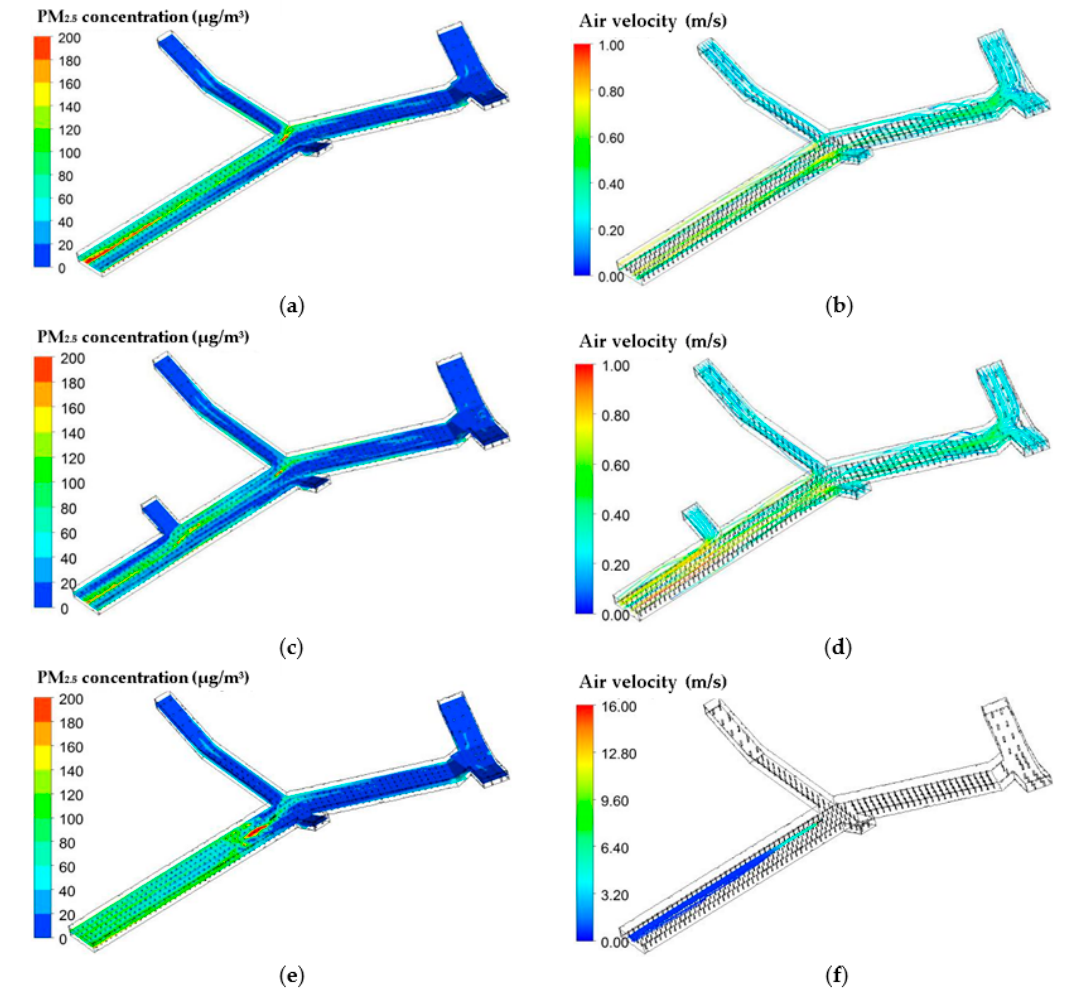
Figure 8. PM 2.5 distribution at the height of 1.5 m and wind streamline of the passageway with different ventilation modes. ( a ) PM 2.5 concentration at the height of 1.5 m in the passageway without ventilation equipment; ( b ) Wind streamline in the passageway without ventilation equipment; ( c ) PM 2.5 concentration at the height of 1.5 m in the passageway with an additional entrance; ( d ) Wind streamline in the passageway with an additional entrance; ( e ) PM 2.5 concentration at the height of 1.5 m in the passageway with a jet fan; ( f ) Wind streamline in the passageway with a jet fan.